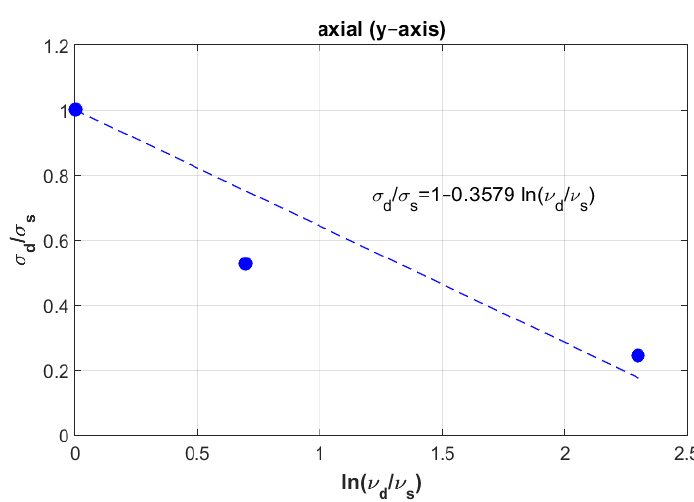
Figure 5. Determination of constant C i in the axial direction (Y).